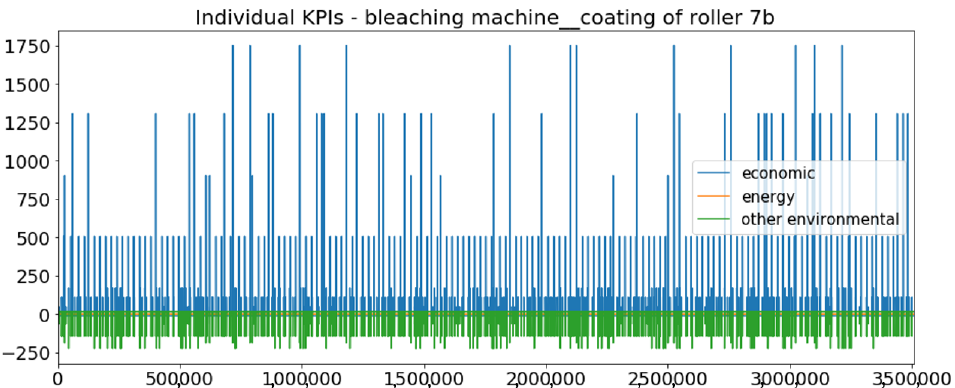
Figure 16. Individual KPI time series for the coating of the bottom roller yielded from running the model with paired coated rollers for the bleaching machine (ZORLUTEKS). The simulation interval has the same length as for training (200 years).